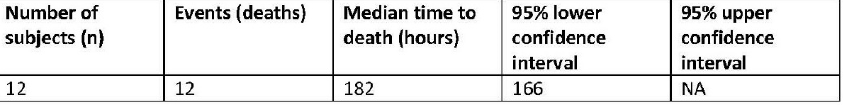
Figure 1. Kaplan–Meier plot of survival of SUDV-challenged cynomolgus macaques. Quantile estimate: Median time (IQR): 188.83 h (165.67 to 236.00).